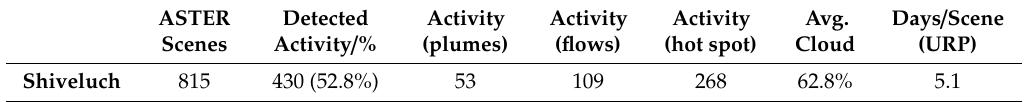
Table 4. Statistical analysis of a single volcano (Shiveluch) from Table 2 active during most of the entire ASTER orbital period (13 April 2000–31 May 2019). Each ASTER scene was inspected for confirmed / detected volcanic activity (e.g., thermally elevated pixels, presence of a plume, etc.) and average cloud cover. The percentage of those URP scenes with confirmed activity is also given and generally correlates to the average cloud percentage.